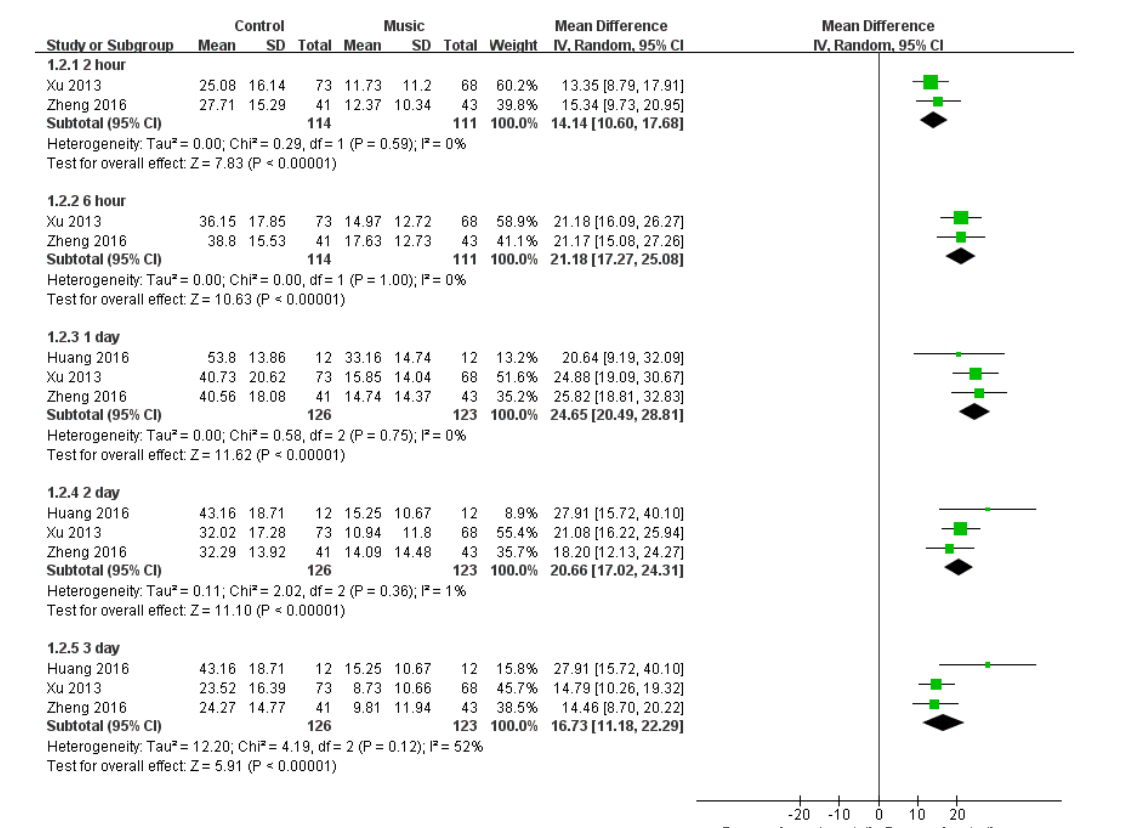
Supplementary Figure 2. Music therapy and control groups for meta-analysis results, reported in mean difference (95% confidence interval), show